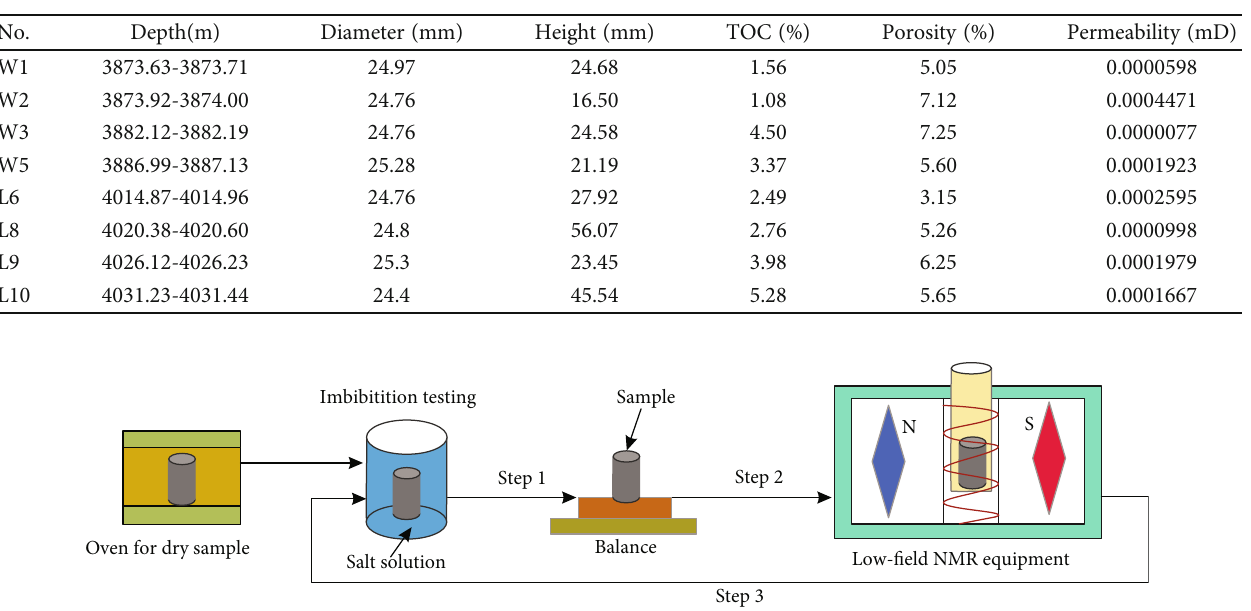
Table 1: Some measured properties of the deep Longmaxi Formation shales samples.